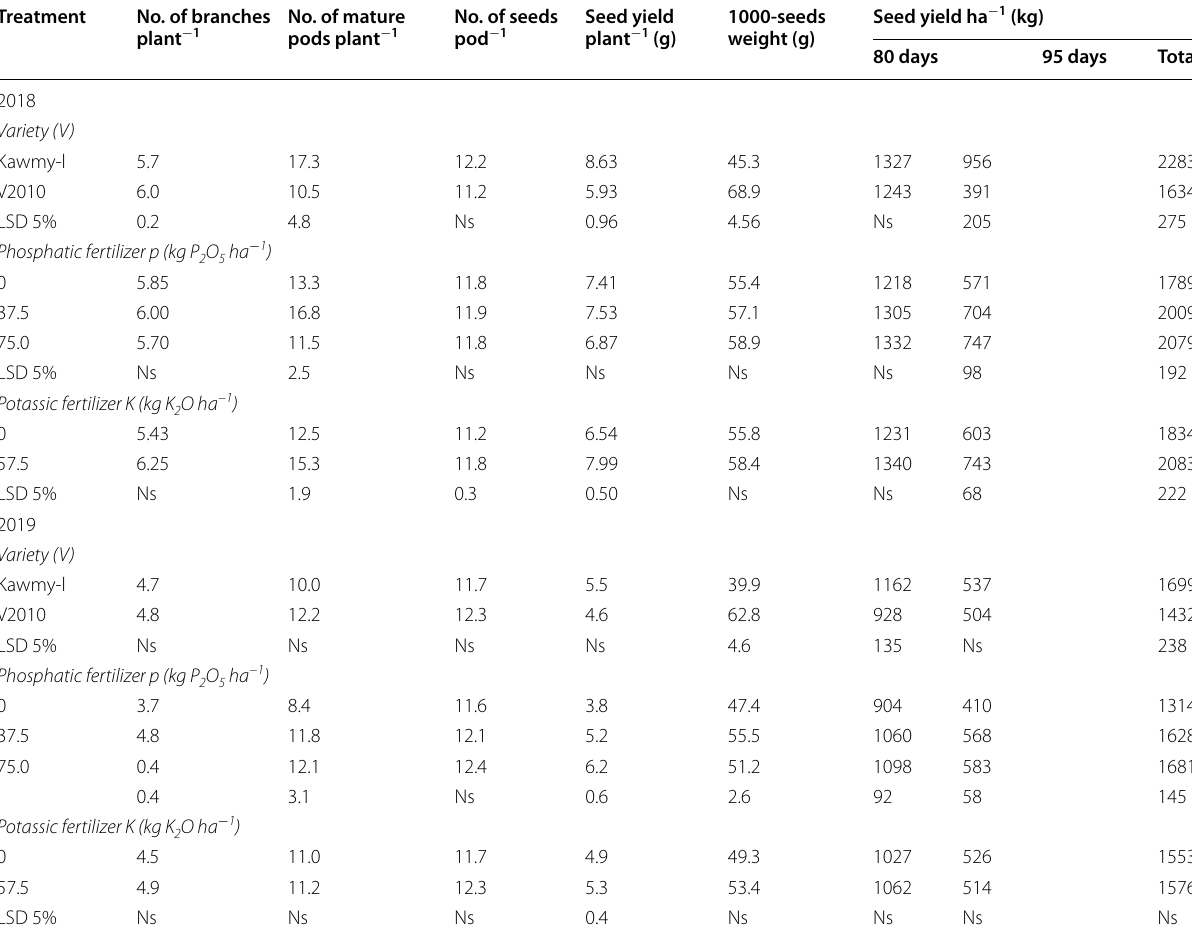
Table 1 Effect of variety, phosphatic and potassic fertilizer levels on mungbean yield and yield components Treatment